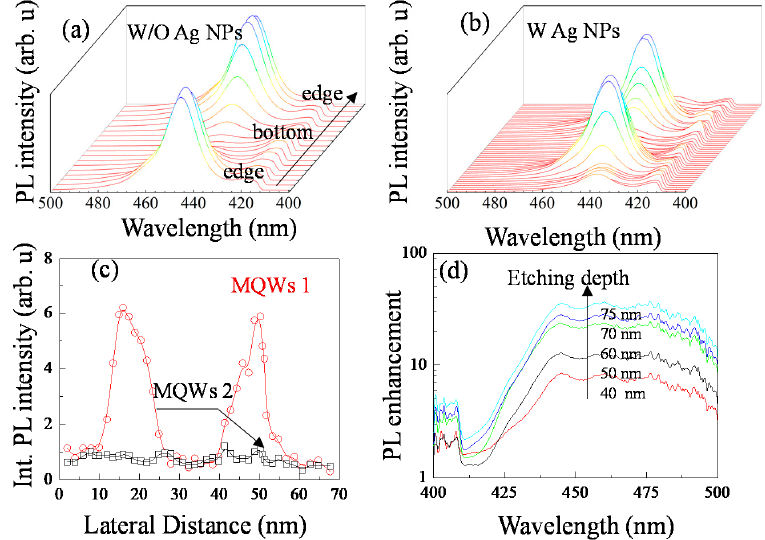
Figure 4. PL spectra at different positions from the outer edge of ( a ) sample 1 and ( b ) sample 2 to the bottom of the microcave. ( c ) The integrated PL intensity of MQWs ‐ 1 and MQWs ‐ 2 at different position of sample 2. ( d ) The relationship between PL enhancement factor and wavelength at different etching distance of sample 2.